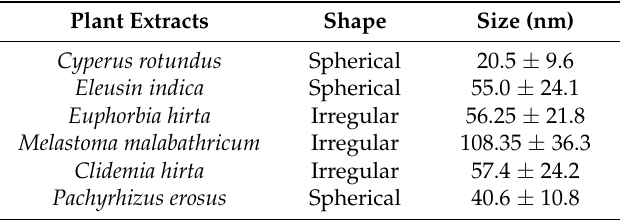
Table 3. Shape and size of AgNPs synthesized using all plants.